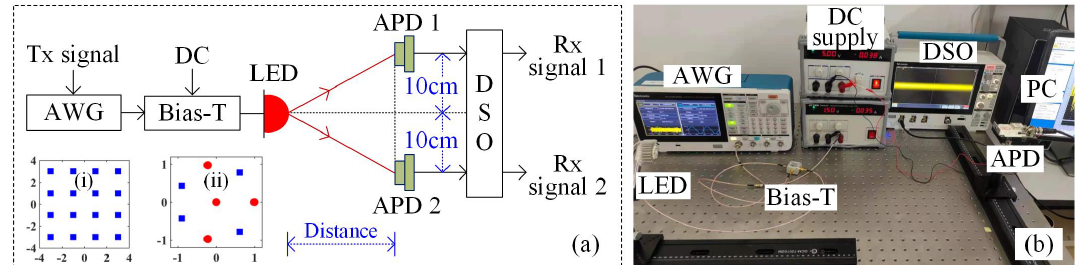
Figure 5. ( a ) Experimental setup of a two-user OSDMA-VLC system and ( b ) the photo of the experimental system.